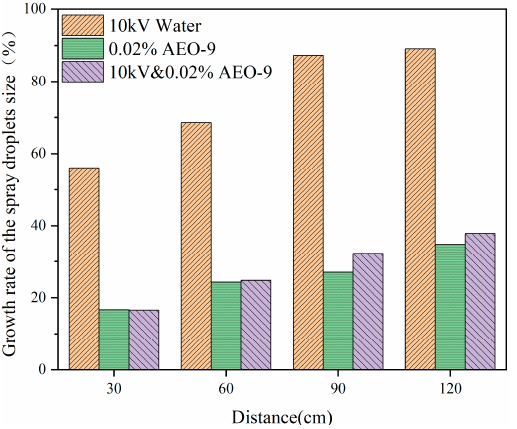
Figure 11. The droplet size growth rate of 10 kV water, 0.02% AEO-9, and 10 kV and 0.02% AEO-9.